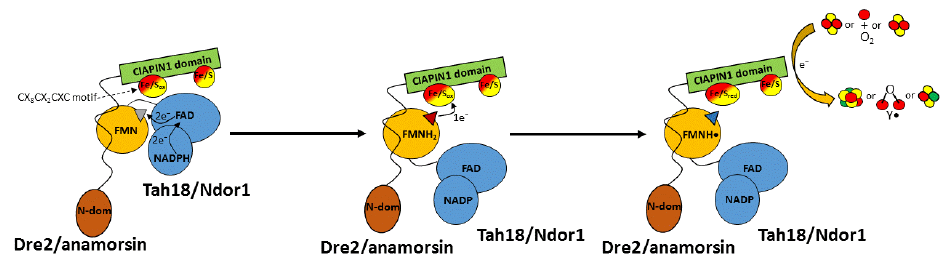
Figure 3. The electron transfer pathway responsible for the formation/reduction of Fe/S clusters and for the formation of the diferric-tyrosyl radical. First, the reduction of the iron-sulfur cluster bound to the CX 8 CX 2 CXC motif of the CIAPIN1 domain occurs following a multistep pathway. Then, this reduced Fe/S cluster transfers one electron at a time to reductively couple two [2Fe-2S] 2+ clusters into a [4Fe-4S] 2+ cluster, to drive the formation of the diferric-tyrosyl radical cofactor in yeast ribonucleotide reductase and to reduce [2Fe-2S] 2+ clusters of human mitoNEET. Red sphere is Fe(III) ion, green sphere is Fe(II) ion, yellow sphere is sulfide ion and red/yellow sphere is Fe/S cluster In summary, biochemical, structural and molecular cell observations indicate that the essential function that the Dre2/Tah18 or anamorsin/Ndor1 complex plays in the CIA ma- chinery is determined by the generation of the electron transfer pathway that terminates in the reduction of the redox-active Fe/S cluster of Dre2/anamorsin, which can thus drive the formation of [4Fe-4S] clusters for cytosolic-nuclear proteins. 4.2. CIAPIN1-Dependent Electron Transfer in the Assembly of the Fe(III) 2 - Y• Cofactor As discussed before, in S. cerevisiae , the Dre2-Tah18 complex also plays a critical role in the formation of the Fe(III) 2 - Y• cofactor in RNR. Since Dre2 and the β subunit of RNR can exist in the same protein complex in vivo [34,49], this is consistent with a model where the redox-active Fe/S cluster of Dre2, once reduced by Tah18, is involved in delivering to the β subunit of RNR the electron that is required for the Fe(III) 2 - Y• cofactor assembly (Fig- ure 3). Moreover, Dre2 interacts in vivo with another component [49] involved in the as- sembly of the Fe(III) 2 - Y• cofactor, which is the cytosolic monothiol glutaredoxin-3 (Grx3, hereafter) [33,35]. The latter, once it forms a heterodimer with the highly homologous pro- tein Grx4 by sharing with it a [2Fe-2S] 2+ cluster at the subunit interface [50], was proposed to play an important role in the delivery of iron to Fe/S, heme, and di-iron requiring pro- teins, including RNR [33,51]. On this basis, it was first postulated that Dre2-Tah18 com- plex might provide the reducing equivalents to allow Fe 2+ ion transfer from the reduced [2Fe(III,II)-2S] + cluster bound at the Grx3/4 dimer interface to apo- ββ′ heterodimer of RNR [34]. However, it was recently shown that, although Dre2 is essential for the assembly of the active Fe(III) 2 - Y• cofactor of RNR, it is dispensable for the first iron-loading step in RNR cofactor assembly [35]. In summary, we believe that in vitro studies are strongly required to shed light on whether the iron ion of the [2Fe-2S] cluster bound to Grx3/4 heterodimers is transferred to RNR as well as which is the species receiving, from the Dre2-Tah18 complex, the electron that is required for the assembly of the Fe(III) 2 - Y• co- factor of RNR. 4.3. A Possible Role of CIAPIN1-Dependent Electron Transfer in the Yeast Viability This electron flow driven by the Dre2-Tah18 complex has also been proposed to be essential for the yeast viability [27]. It is possible indeed that the disruption of the Dre2- Tah18 complex in vivo in the presence of high levels of hydrogen peroxide not only allows